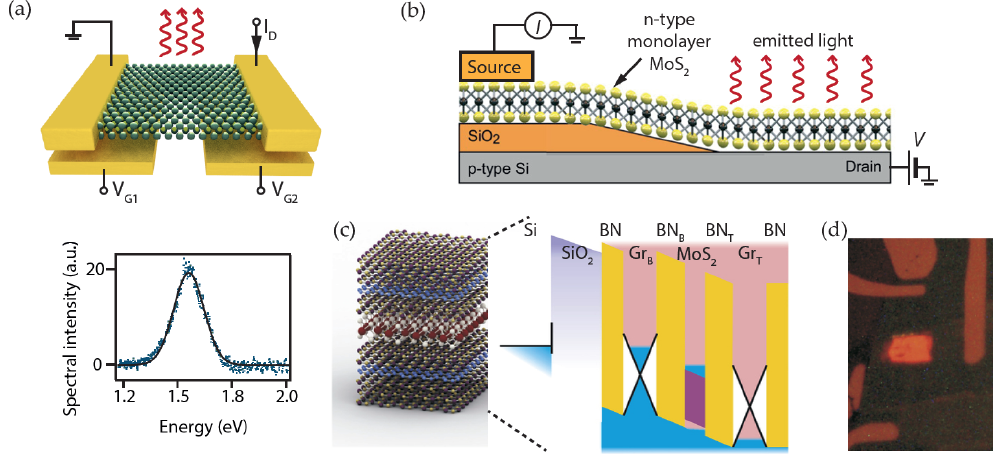
Figure 5. Light emitting devices. ( a ) Lateral device design (top). Split-gate electrodes couple Figure 5